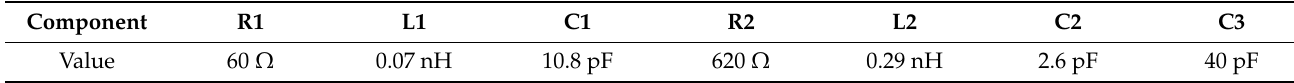
Table 3. Values of the